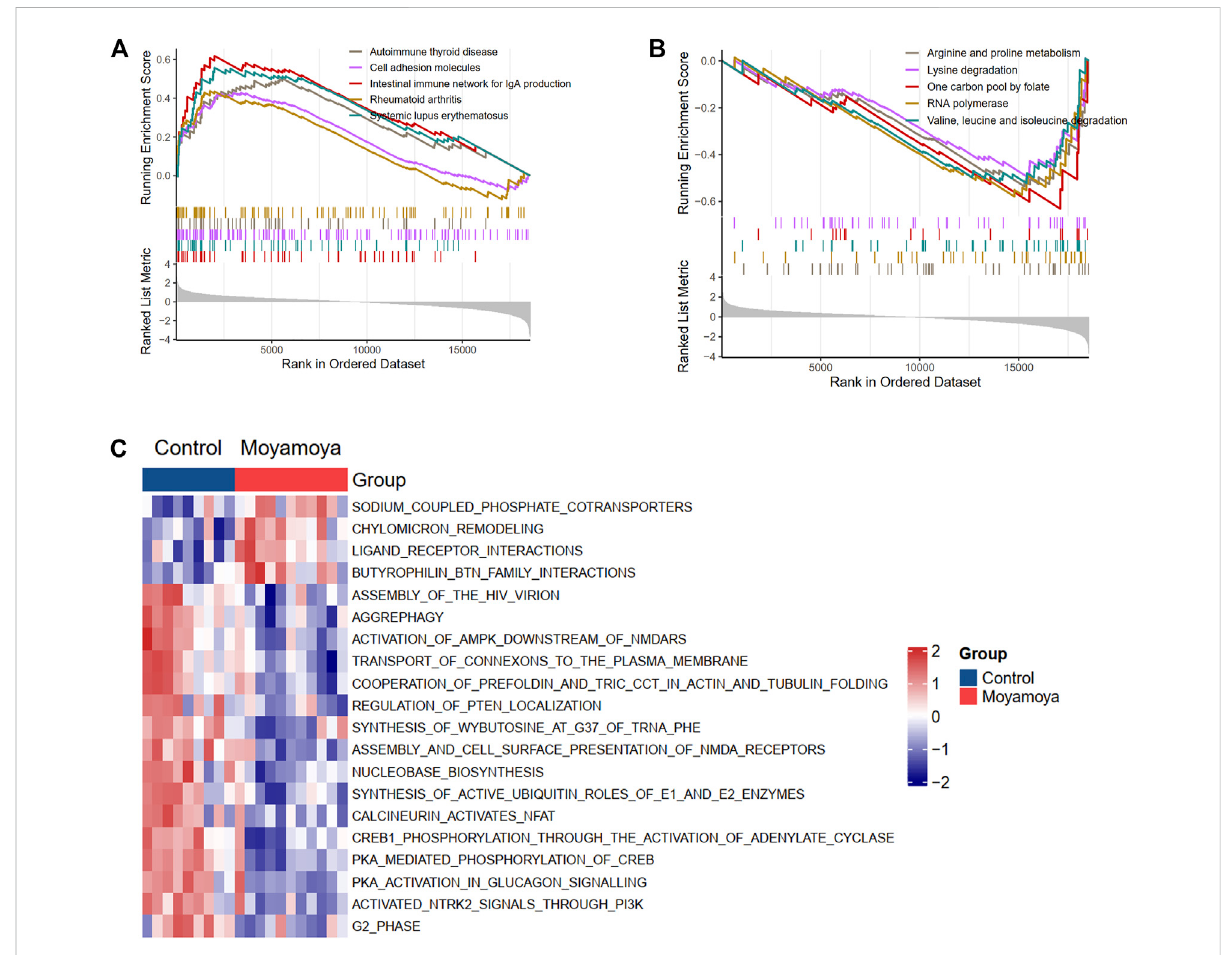
FIGURE 3 Biological KEGG and Reactome pathways involved in MMD based on GSEA and GSVA. (A) and (B) Up-regulated and down-regulated KEGG pathways from GSEA results, respectively. (C) The top differentially regulated reactome pathways from GSVA